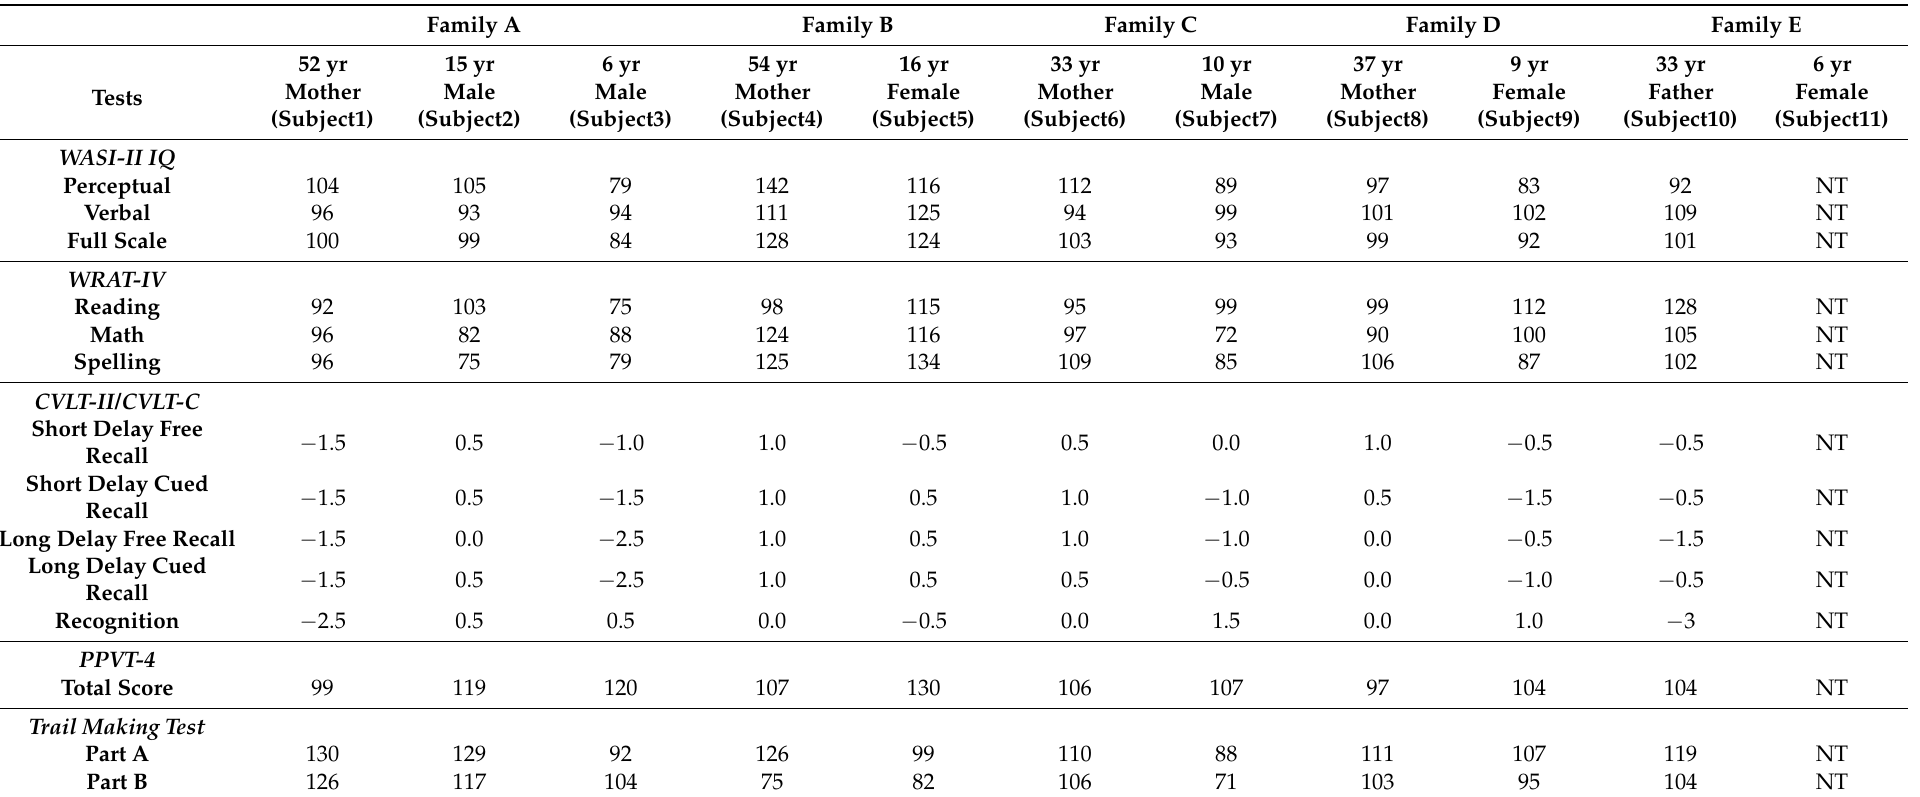
Table 1. Cognitive testing and results for families with 15q11.2 BP1-BP2 deletion. Family A Family